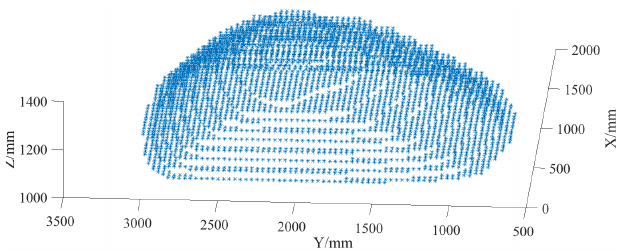
Figure 24. Compressed point cloud data.